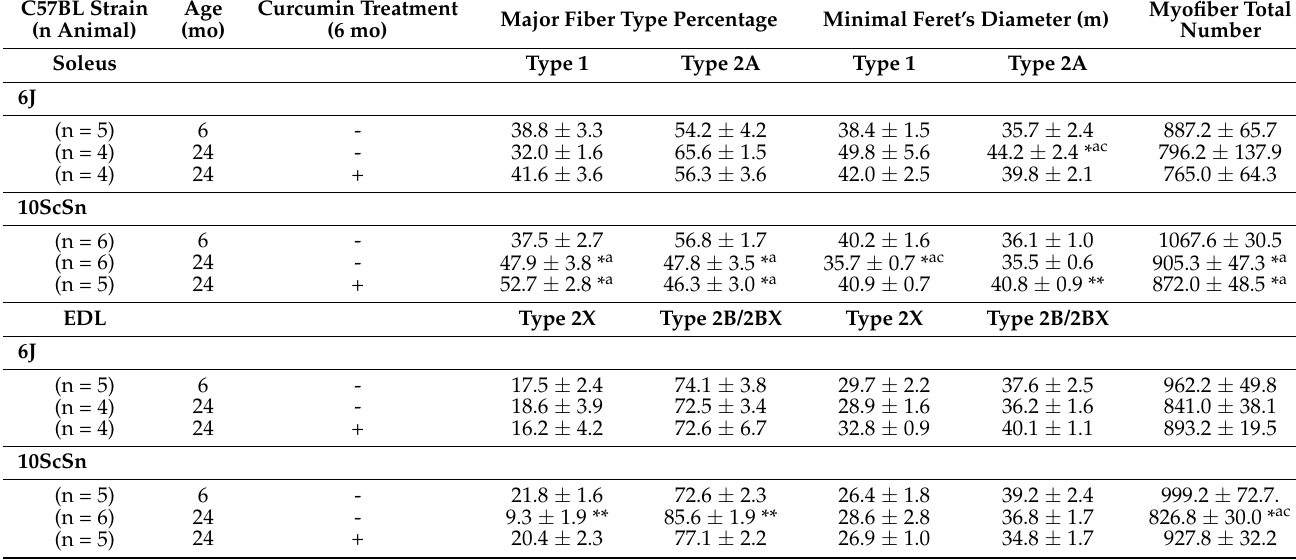
Values correspond to mean and SEM. ANOVA and post-hoc: * a p ≤ 0.05 vs. adult; * ac p ≤ 0.05 vs. all; ** p < 0.01 vs.